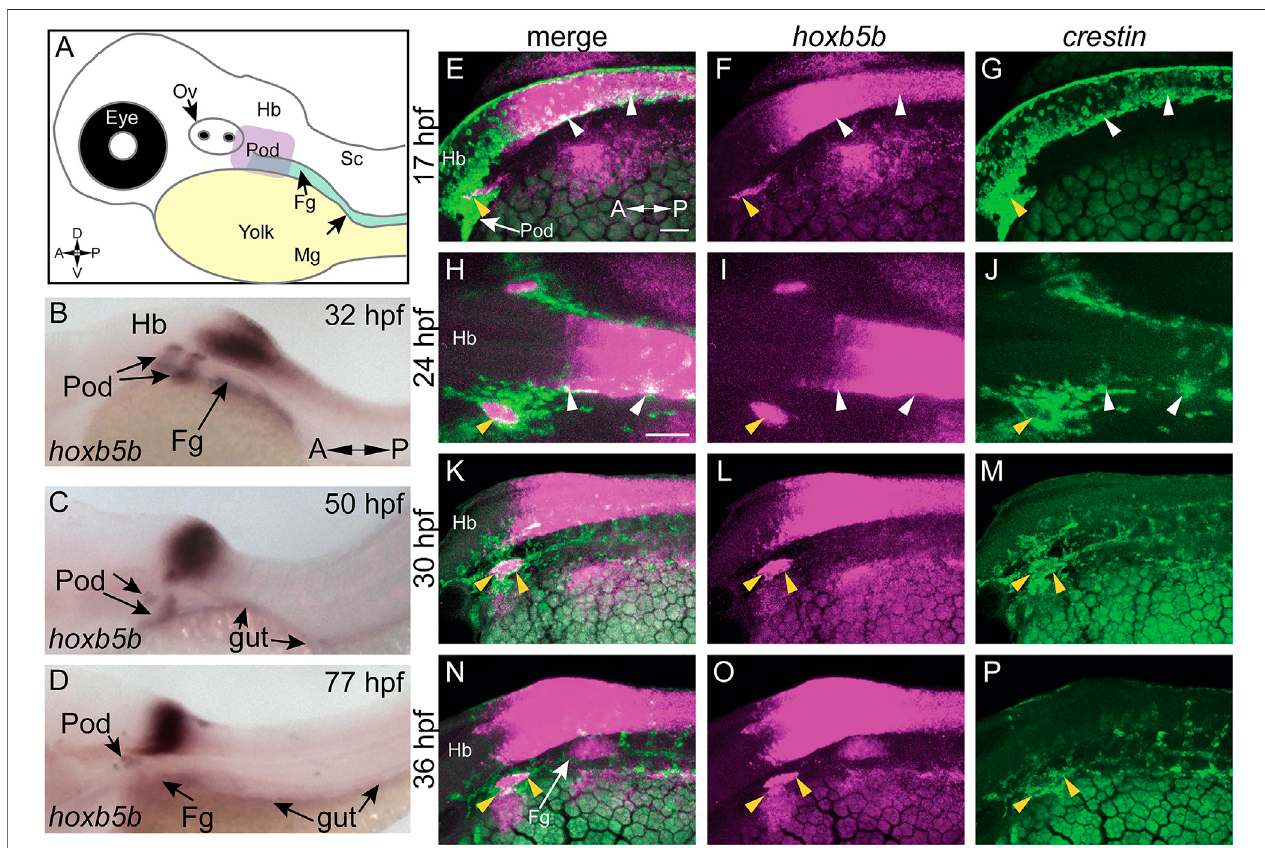
FIGURE1| hoxb5b isexpressedduringearlyNCCdevelopment. (A) Schematizedembryoillustratingapproximatelocationsofmajorrelevantanatomicalfeatures, namely the post-otic domain (POD), eye, yolk,Otic Vesicle (Ov), Hindbrain (Hb), presumptive spinal cord (Sc), foregutmesenchyme (Fg), and Midgutmesenchyme (Mg). (B – D) in situ hybridizationdemonstrating hoxb5b expression in theposterior Hb, POD, and Fg during thesecond through third day ofdevelopment. (E – P) Hybridization Chain Reaction probes against crestin and hoxb5b highlight their overlapping domains in the POD (yellow arrowheads) and along the dorsal length (white arrowheads). Scale bars E,H: 50 μ